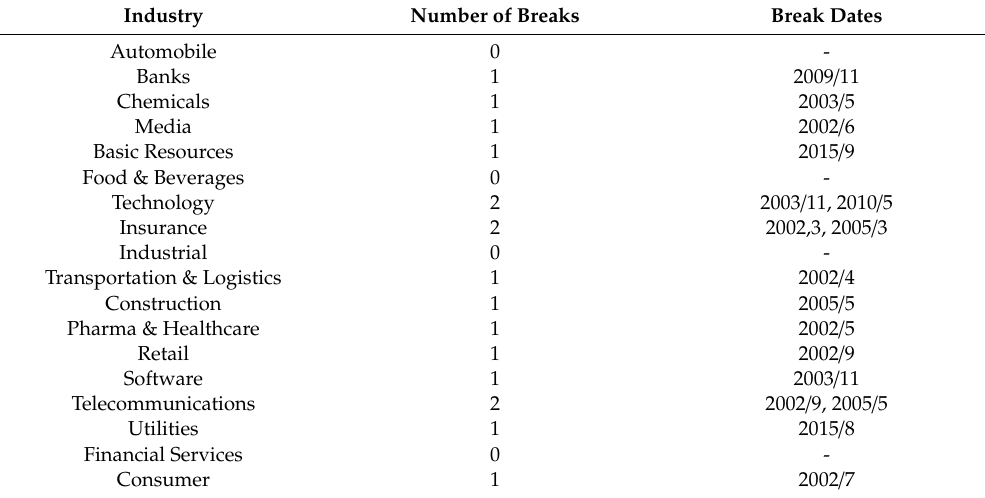
Table 3. Testing for structural change—the three factor models.